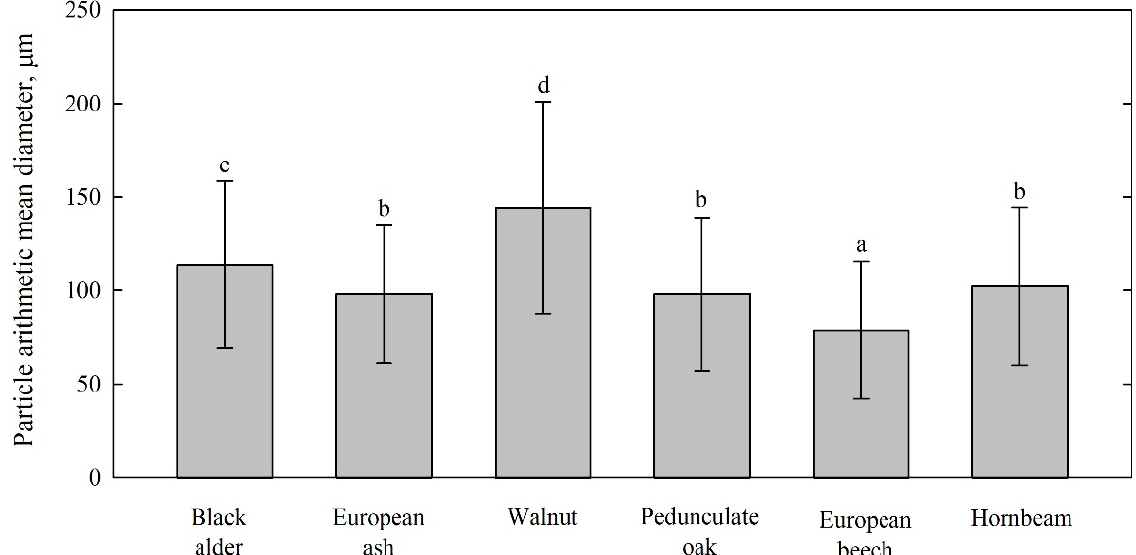
Figure 3. Particle mean diameter of the hardwood species investigated in this work (identical superscripts a, b, c, denote no significant difference for p < 0.05, error bars represent the standard de ‐ viation).